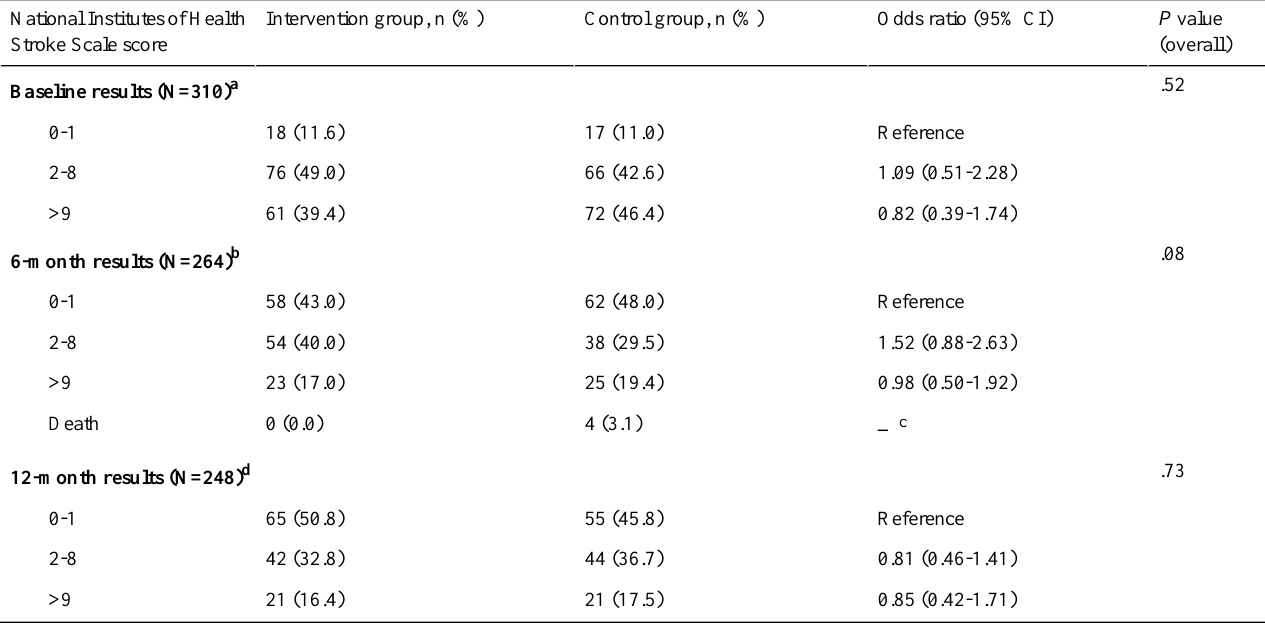
Table 8. National Institutes of Health Stroke